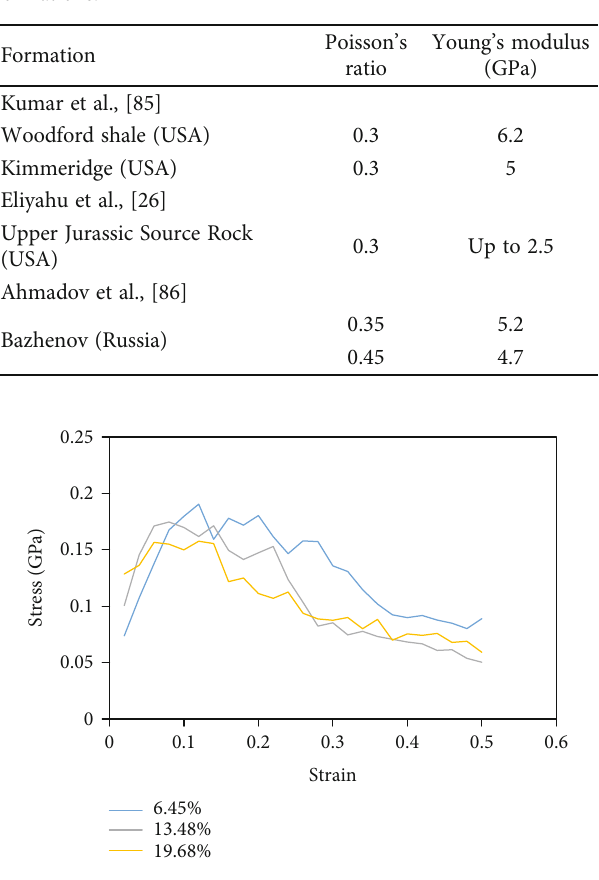
Figure 11: Tensile mechanical deformation of kerogen structures with a porosity range of 6.45% to 19.68%. Three cases were shown to avoid